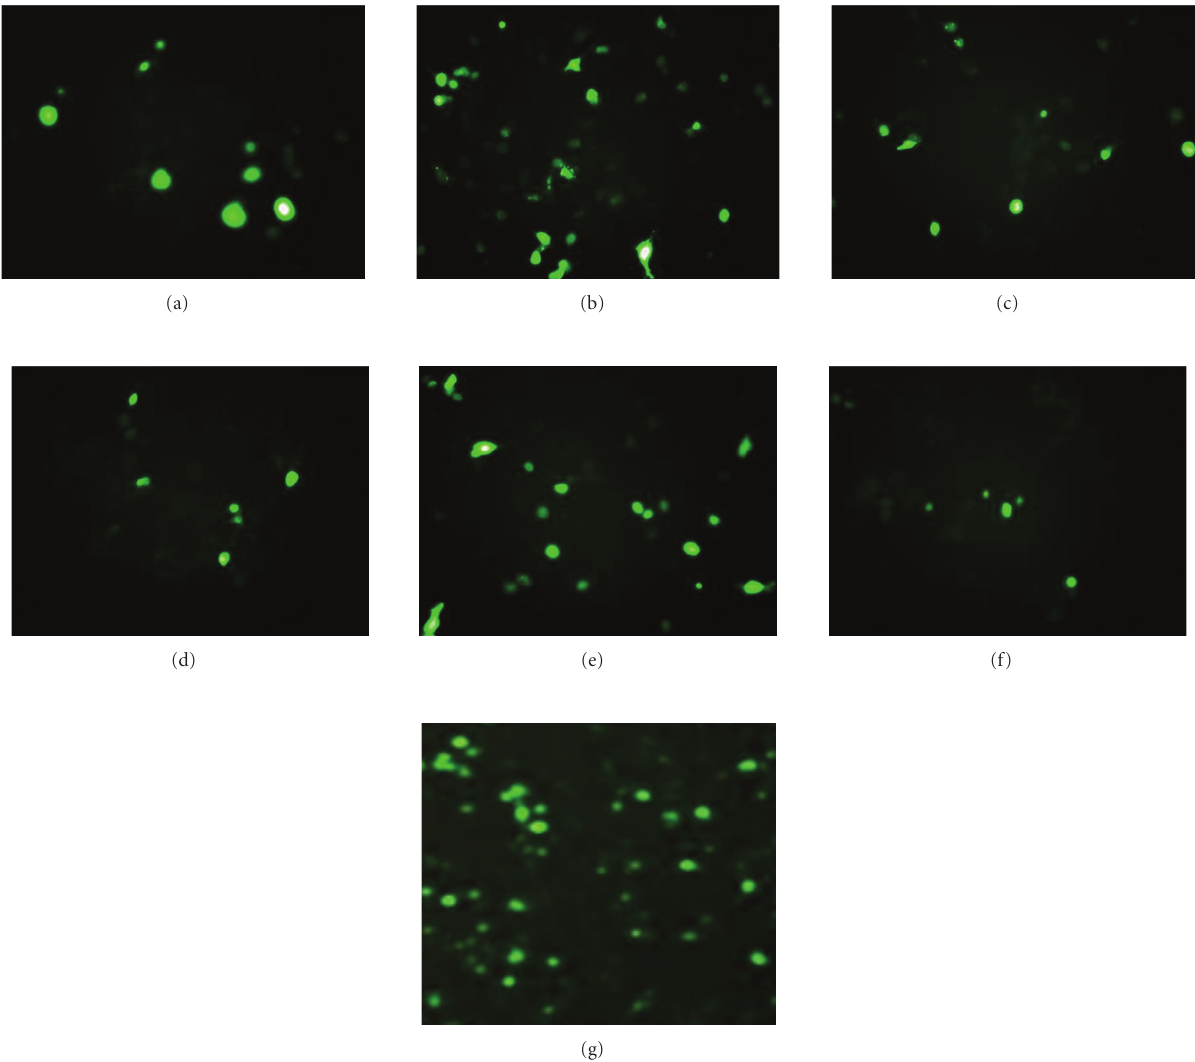
Figure 2: Expression of Pokemon-GFP in MCF7 cells cotransfected with the pEGFP(N2)-Pokemon and di ff erent shRNA expression plasmids. (a) MCF7 cells cotransfected with the pEGFP(N2)-Pokemon and SP1, (b) with the pEGFP(N2)-Pokemon and SP2, (c) with the pEGFP(N2)-Pokemon and SP3, (d) with the pEGFP(N2)-Pokemon and EP1, (e) with the pEGFP(N2)-Pokemon and EP2, (f) with the pEGFP(N2)-Pokemon and EP3, and with the (g) pEGFP(N2)-Pokemon and